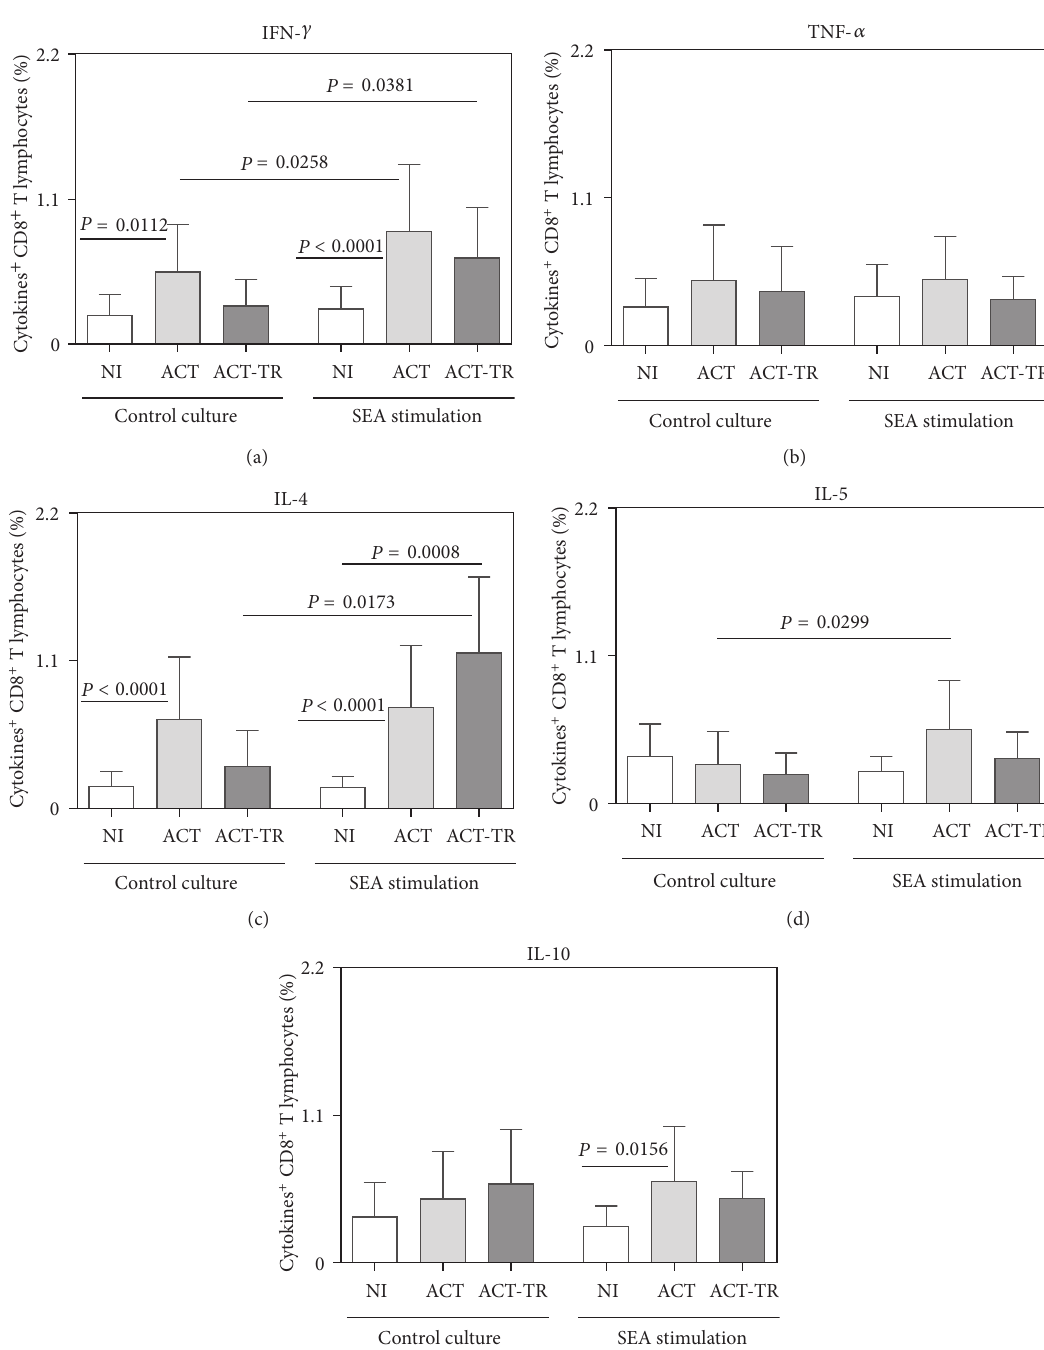
F 4: Cytokine pattern of circulating T CD8 -lymphocytes from patients with acute Schistosomiasis mansoni before (ACT, faint grey square = 21) and aer praziquantel treatment (ACT-TR, grey square = 07) and noninfected individuals (NI, white square = 19), following + short-term in vitro cultivation in the absence (control culture) or presence of SEA stimulation. e results are shown in bar-plot format highlighting the mean percentage of datasets standard deviation. Statistically signi�cant di�erences (connecting lines) observed between groups NI, ACT, and ACT-TR were considered at ± 𝑃𝑃 𝑃 𝑃𝑃𝑃𝑃